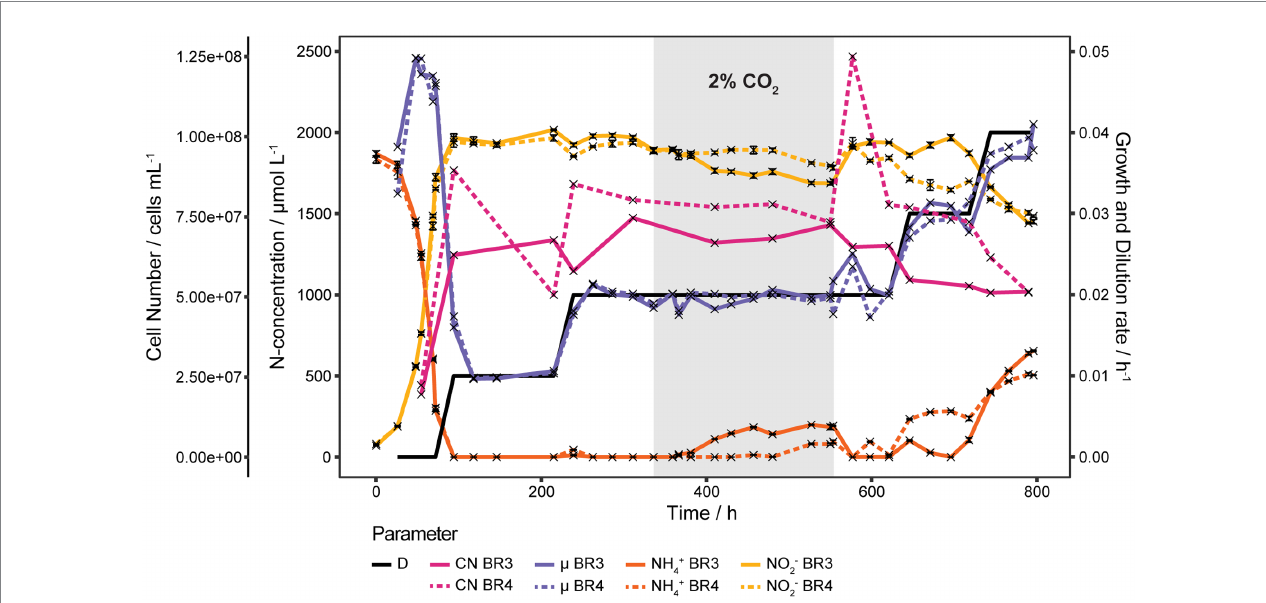
FIGURE 4 Continuous cultures of N. viennensis at low D . Two continuous cultures operated at D from 0.010 h − 1 to 0.040 h − 1 and the development of cell number (CN), NO 2 − derived μ , NH 4+ and NO 2 − concentrations of the cultures grown in the corresponding reactors BR3 and BR4. Cultures were gassed with 2 sL L − 1 h − 1 0.5% CO 2 enriched air, except for the gray area where CO 2 was increased to 2%. The elevated CO 2 concentration induced an increase of NH 4+ with a delay of 55.5 h and 216 h in BR3 and BR4, respectively. NH 4+ was consumed again right after decreasing CO 2 back to 0.5% which coincided with a temporary increase of the cell number in BR4. NH 4+ and NO 2 − curves show mean values of technical triplicates and error bars represent the standard deviation of the mean. Points with small standard deviation may not have visible error